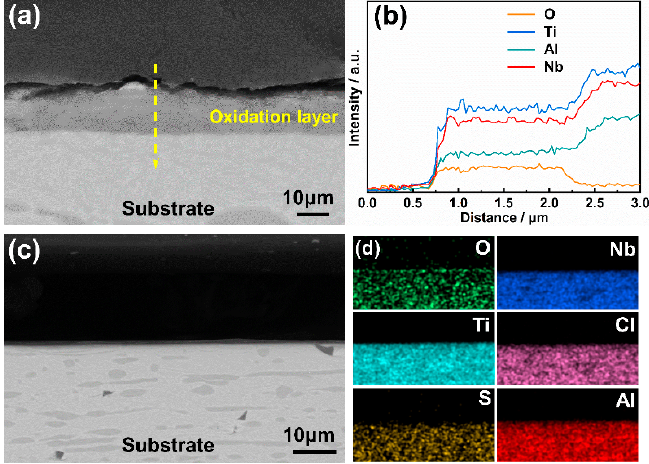
Figure 7. Cross-sectional SEM images and EDS spectra of the tested samples: ( a , b ) High temperature oxidation test; ( c , d ) Salt spray test.